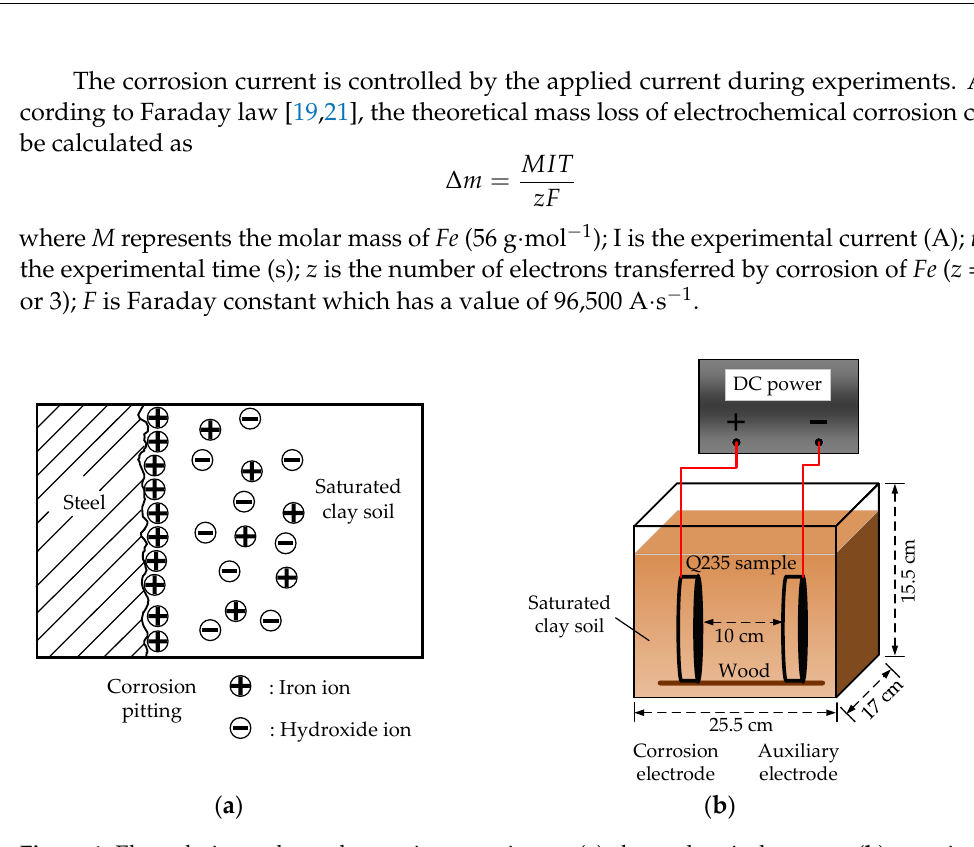
Figure 1. Electrolytic accelerated corrosion experiment: ( a ) electrochemical process; ( b ) experimental system.